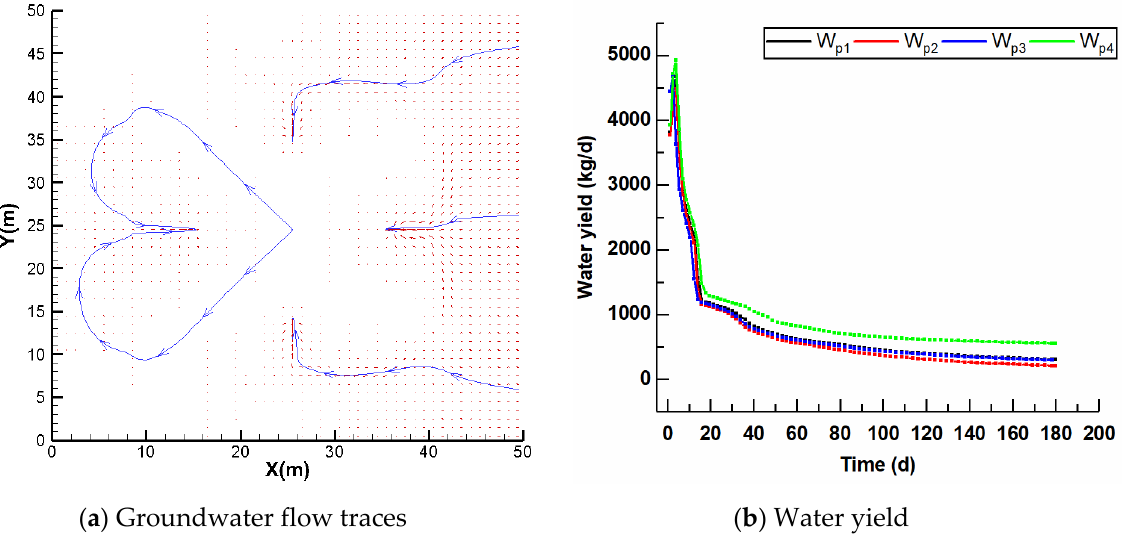
Figure 4. Groundwater flow traces and water yield of the production wells.